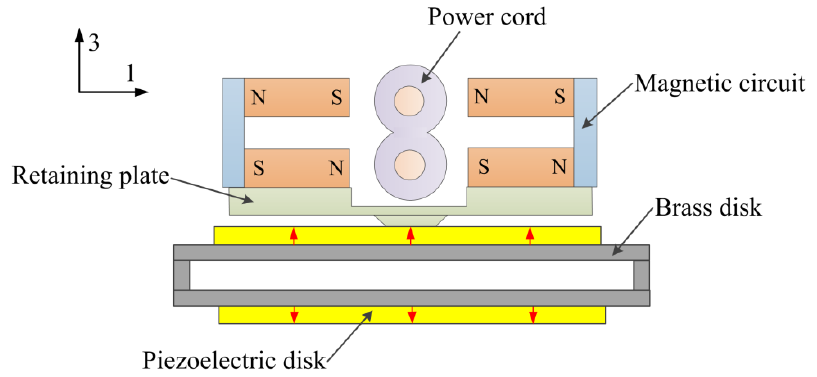
Figure 1. Schematic diagram of the current sensor.